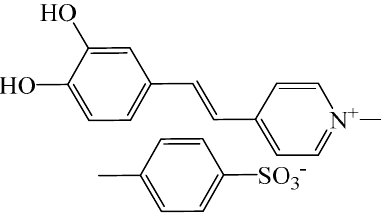
Figure 6. Molecular structure of 3 ′ , 4-dihydroxy-4- N -methylstilbazolium tosylate.